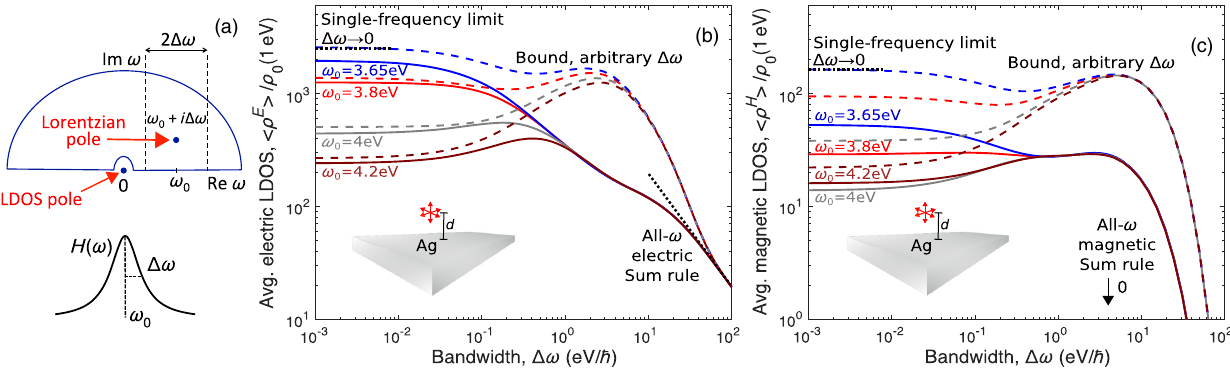
FIG. 4. (a) Contour of integration in the complex- ω plane used to obtain the average LDOS, which contains singularities at the origin ( “ LDOS pole ” ) that is intrinsic to LDOS and at a complex frequency ( “ Lorentzian pole ” ) determined by the parameters chosen for the Lorentzian window function H ω . Apart from these two poles, the product ρ H ω is analytic everywhere on the upper half plane. 0 ; Δ ω 0 ; Δ ω (b) Average electric and (c) magnetic LDOS near a Ag half-space centered at different frequencies around its peak (3.65 eV), compared to their respective bounds. Taking the bandwidth to zero gives the single-frequency limit found in earlier works [36,37]. In the opposite limit of infinitely large bandwidth that includes the entire LDOS spectrum, our bounds reproduce the electric and magnetic sum rules in Sec. II A. The emitter-scatterer distance d is set to 10